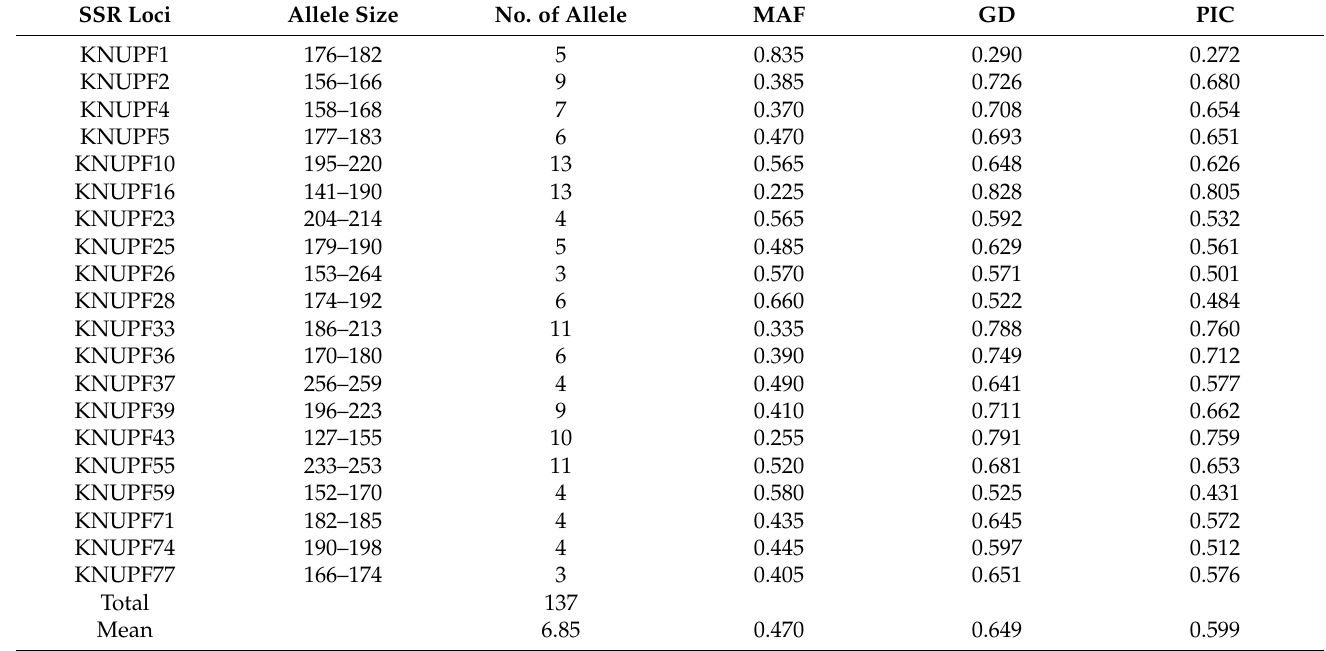
Table 2. Characteristics of the 20 Perilla SSR loci including allele size, number of allele, MAF, GD, PIC among 200 accessions of native Perilla frutescens var. frutescens of Perilla